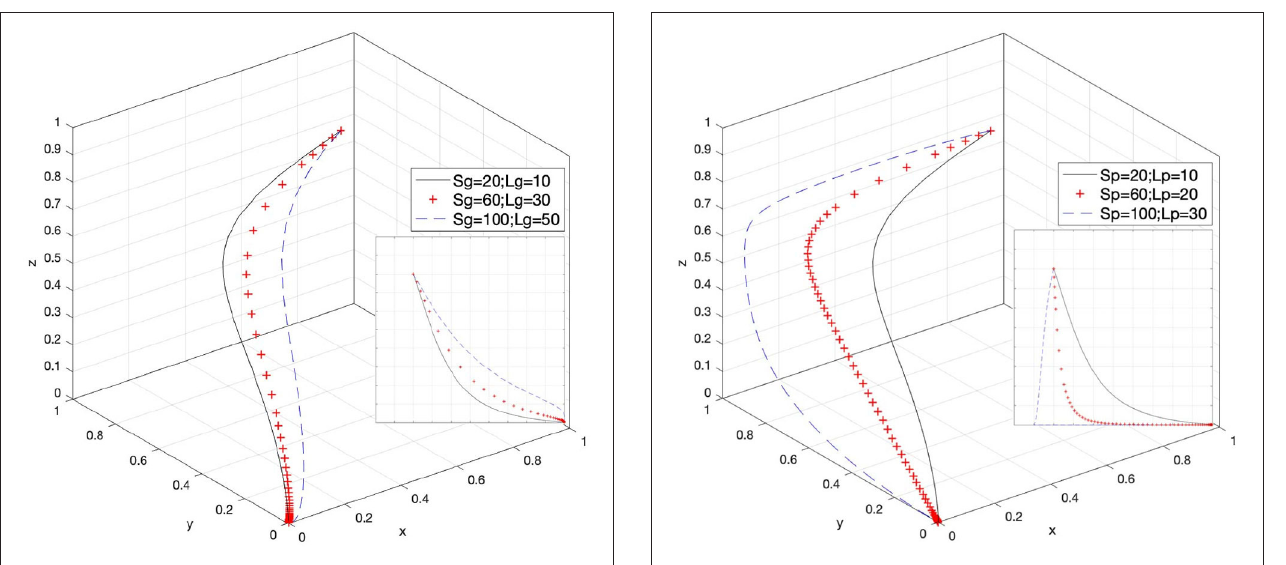
FIGURE 6 | Effect of the social benefits of the government’s supervision. FIGURE 7 | Effect of the social benefits of e-commerce platforms’ response